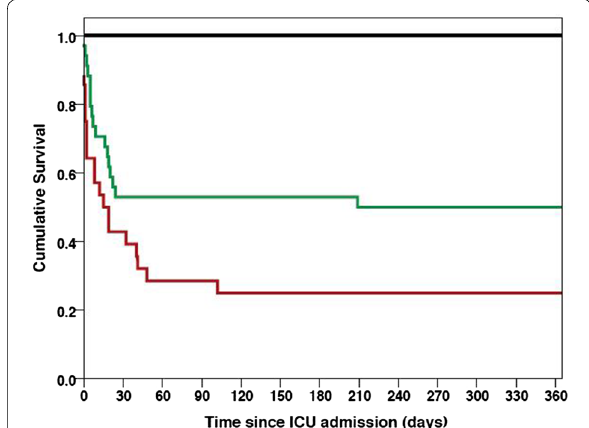
Fig. 3 Kaplan–Meier survival curve stratified by Child–Pugh class at ICU admission. Black lines Child–Pugh class A ( n Child–Pugh class B ( n 34). Red lines Child–Pugh class C ( n = Log-rank p value 0.002 =